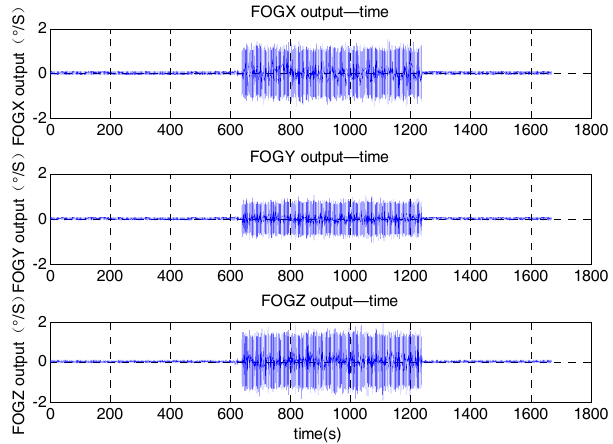
Figure 8. Raw data of the FOGs in the random vibration.